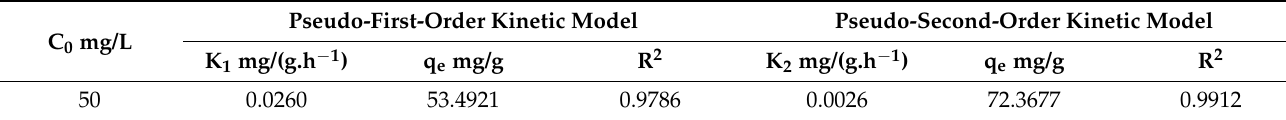
Figure 6. ( a ) Kinetic fitting of T-BSA, ( b ) isotherm model fitting of Cr(VI) adsorption by T-BSA. Table 3. T-BSA kinetic fitting parameters.